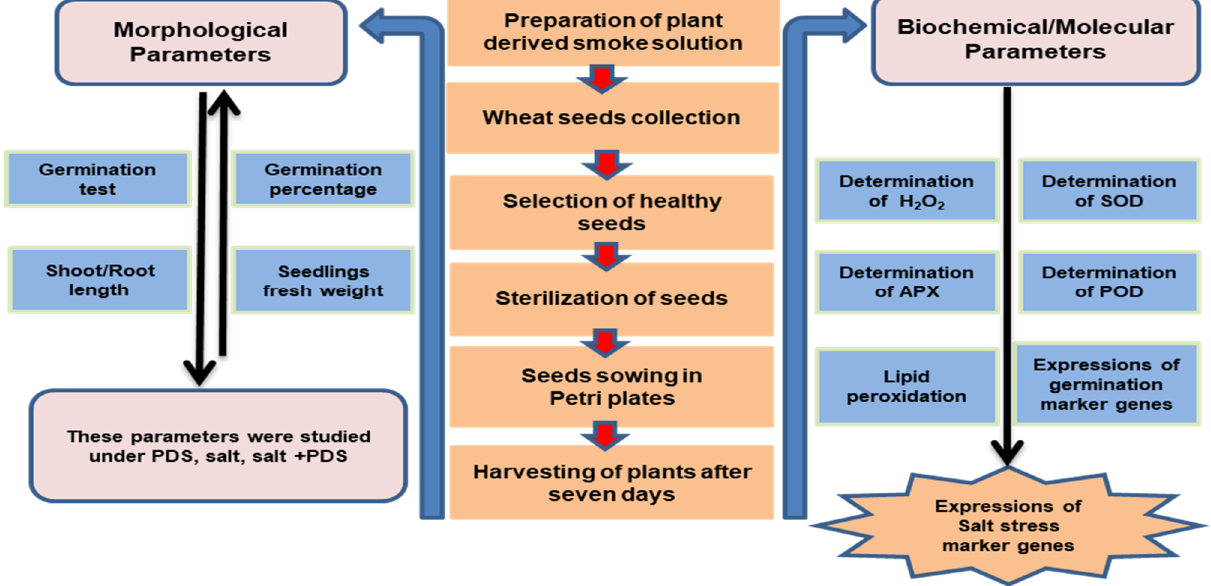
Figure 7. The effects of PDS on wheat growth were studied using an experimental design. Wheat seeds were treated with 500, 1000 and 2000 ppm PDS followed by selection of 2000 ppm for allevi- ation experiment based on best promoting effects. Wheat seeds were given salt stress (150–200 mM), which caused inhibition of seed germination and seedling growth. Supplementation of PDS at 2000 ppm concentration alleviated the salt stress. Figure 6 is schematic representation of stepwise exper- imental layout of morphological, physiological, and molecular